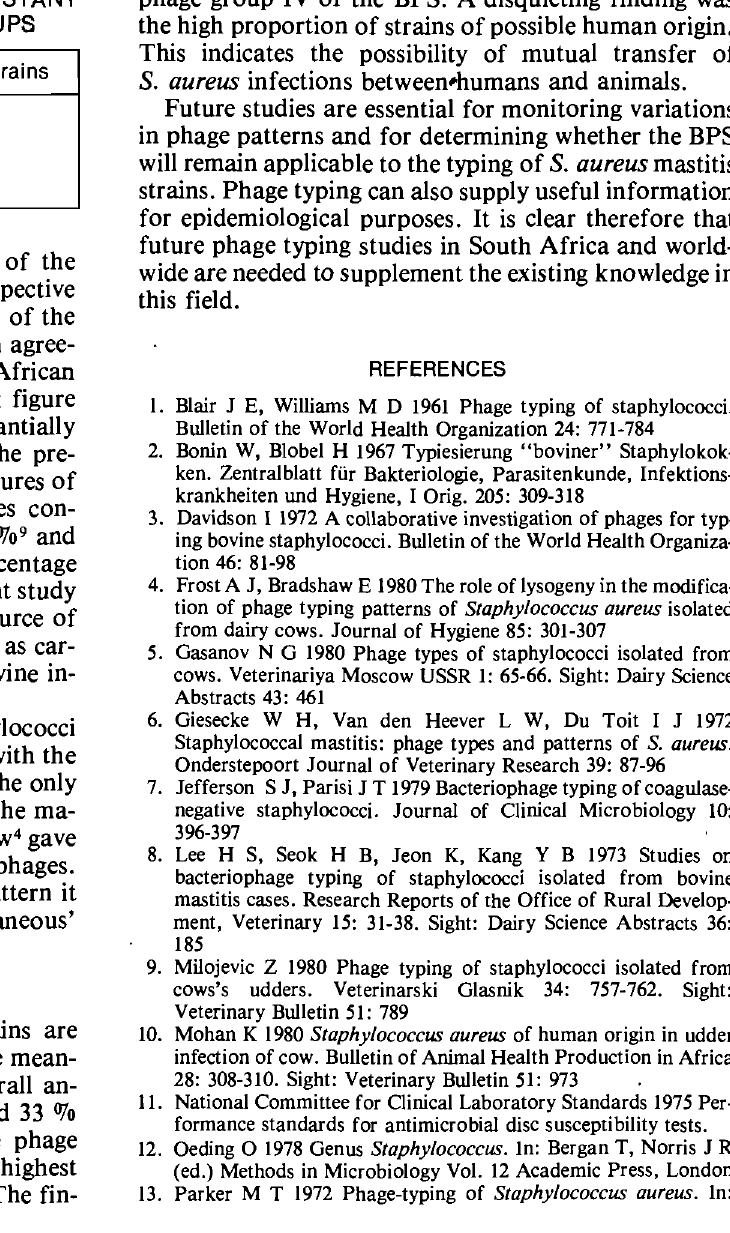
Table 2: INCIDENCE OF ANTIBIOTIC MULTIRESISTANT S. AUREUS STRAINS IN HPS PHAGE